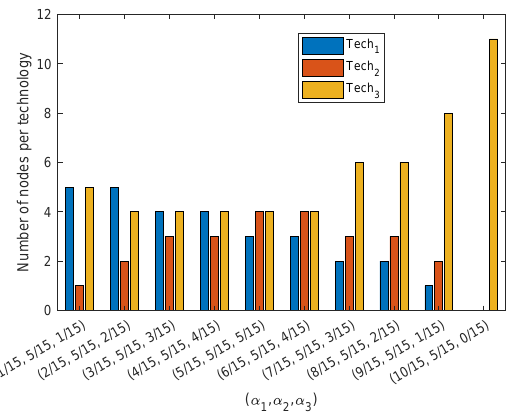
Figure 9. Number of purchased nodes per technology as a function of the maximum CAPEX available during the design process of the Sprint network ( n = 11 nodes).